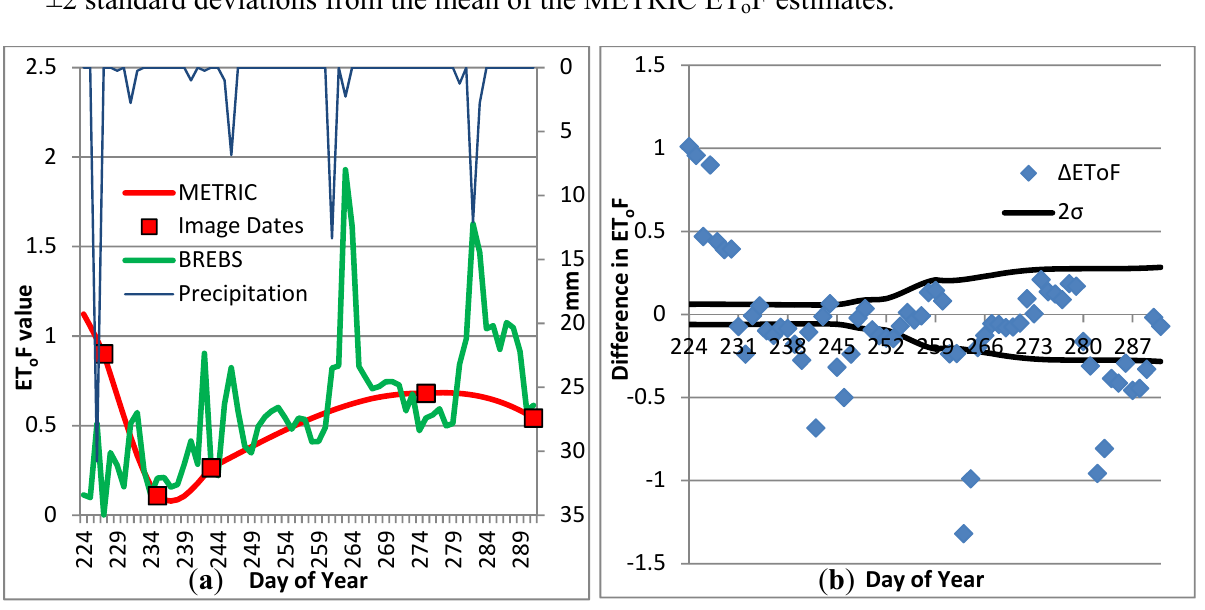
±2 standard deviations from the mean of the METRIC ET